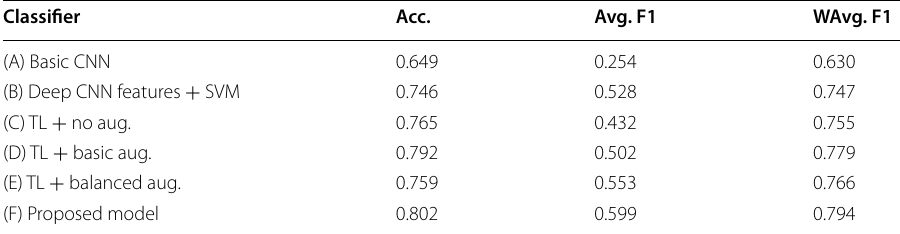
Table 6 Dynamic sampling with network camera image data [21]